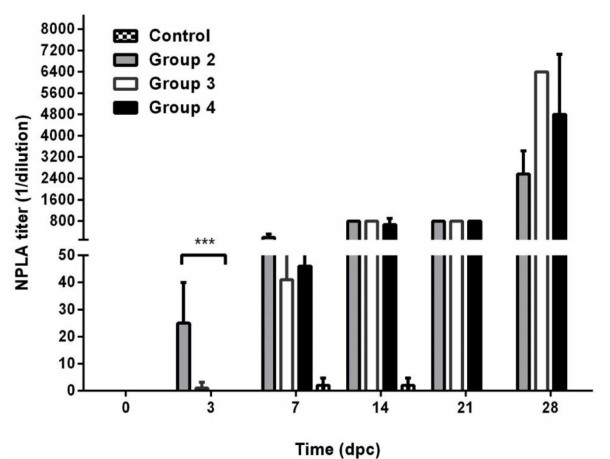
Figure 3. Neutralizing antibodies titres. Bars represent the geometric mean of the antibody titres plus the 95% confidence interval. Group 1: control animals. Group 2: animals immunized once five days before challenge. Group 3: animals immunized once three days before challenge. Group 4: animals immunized once one day before challenge. Dpc: days post-challenge. *** p <